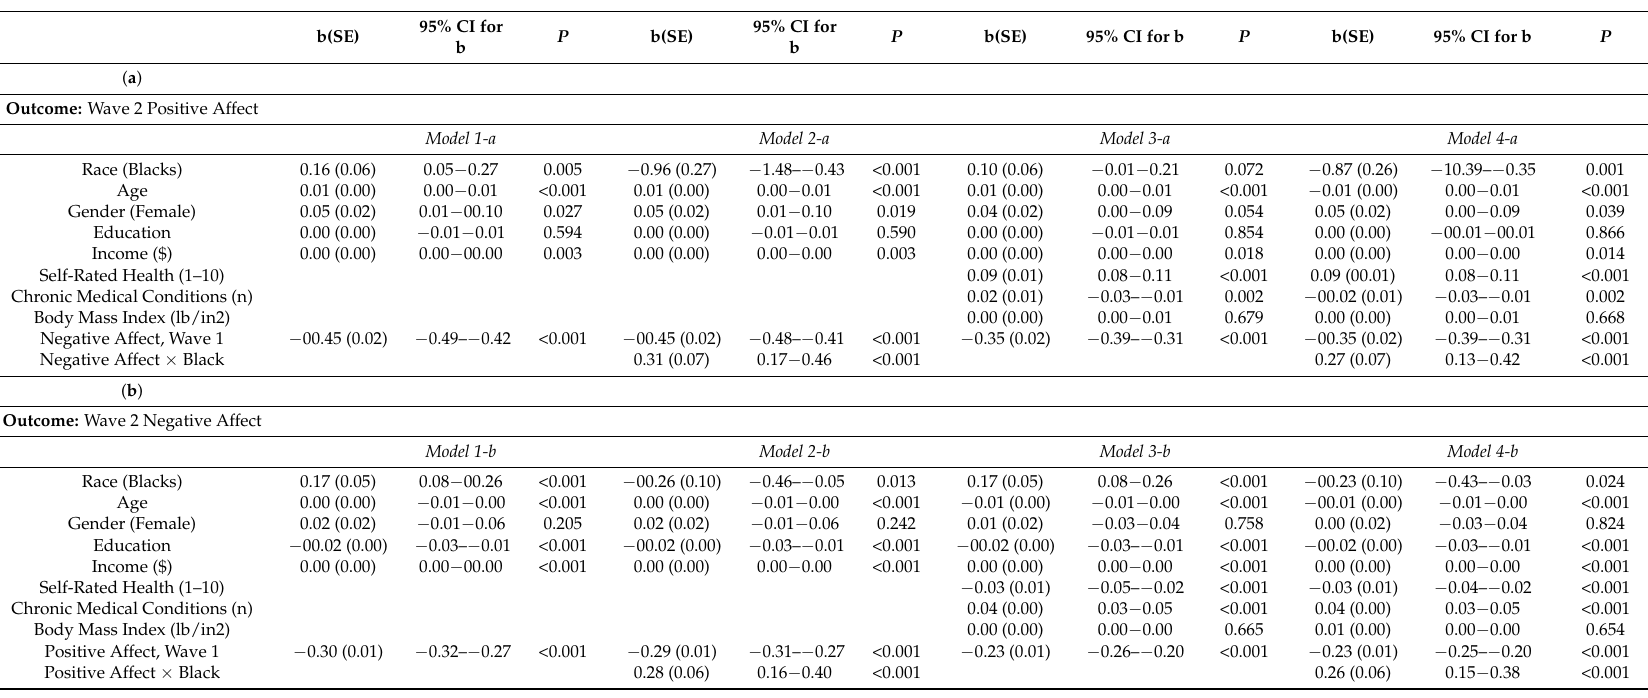
Table 4. Predictors of wave 2 positive and negative affect in the pooled